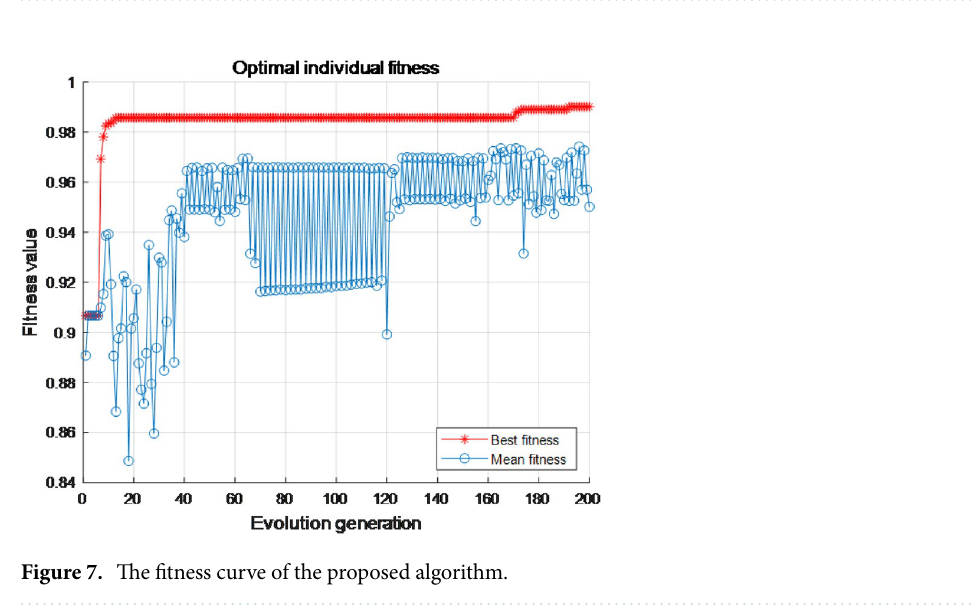
Table 8. Results of different recognition algorithms. Significant values are in bold.